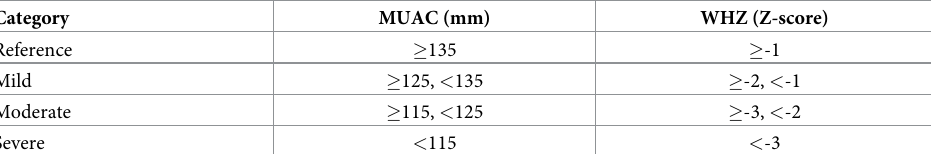
Table 1. Category definition of the determinant variables mid-upper arm circumference (MUAC; in mm) and weight-for-height Z-score